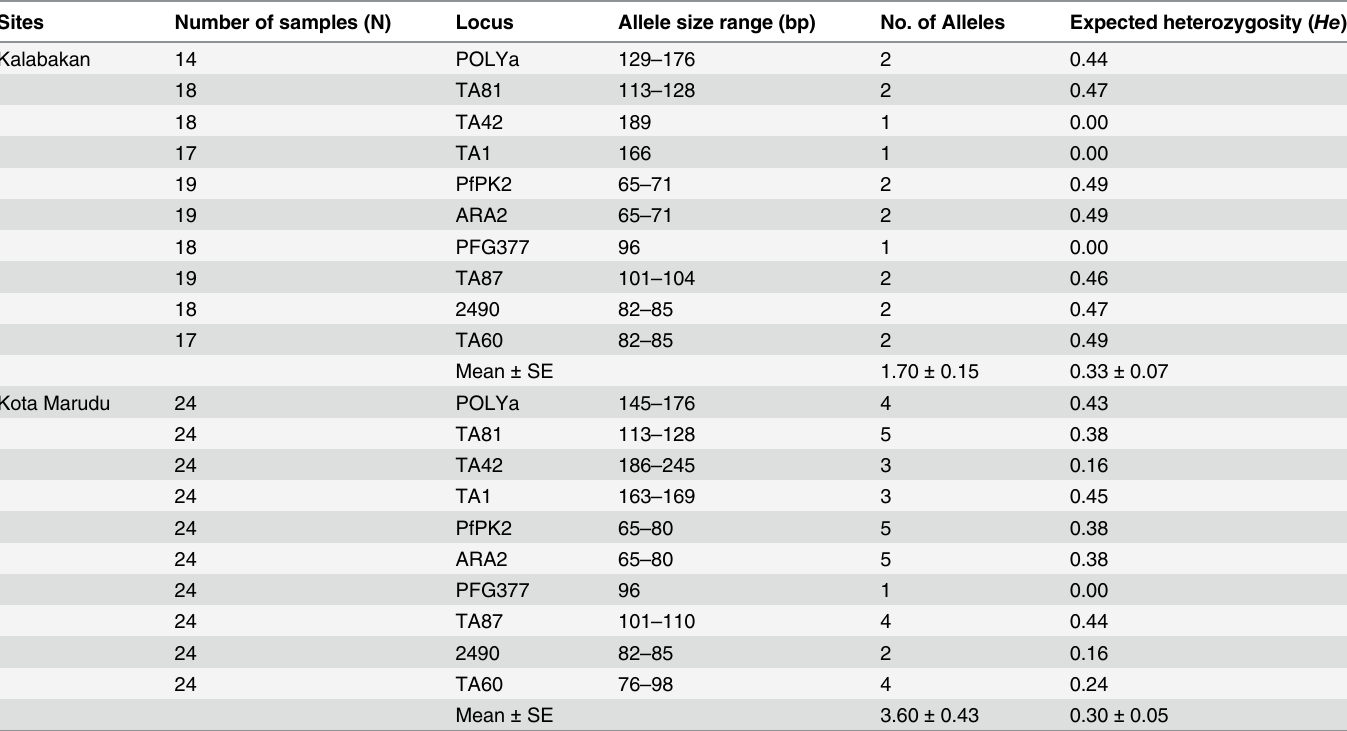
Table 6. Distribution of 10 microsatellite loci of P . falciparum isolates in Kalabakan and Kota Marudu. Sites Number of samples (N)